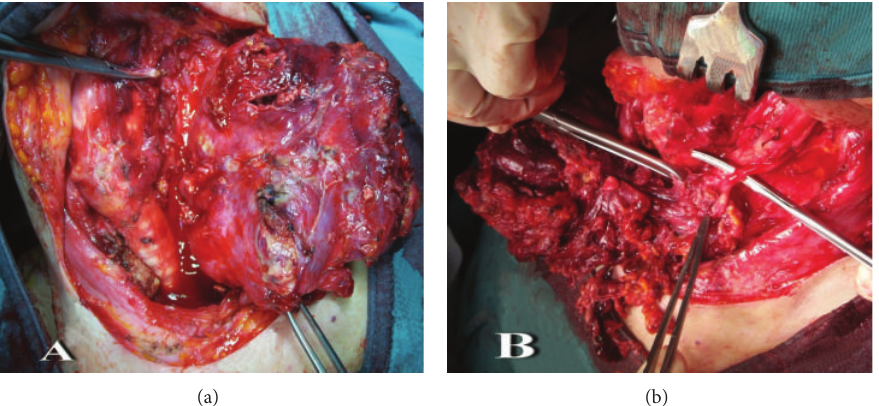
Figure 3: (a) Intraoperative image of the tumor originating from the left thyroideal lobe stuffed of blood; (b) the left vagus nerve, completely embedded by the